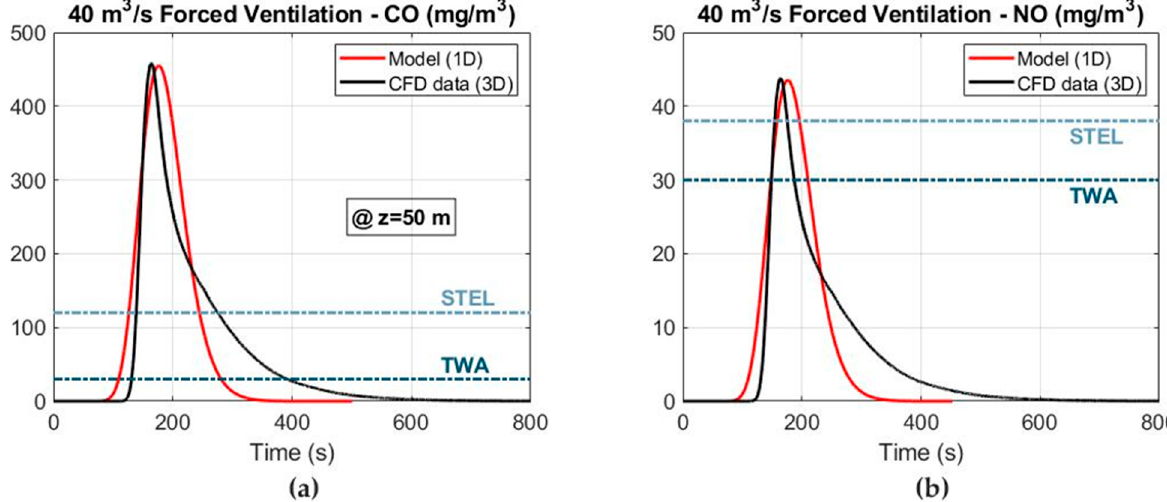
Figure 9. Comparative analysis between the 1D model and the 3D numerical simulations at the cross section of Z = 50 m under forced ventilation: ( a ) CO mass concentration and ( b ) NO mass concentration.